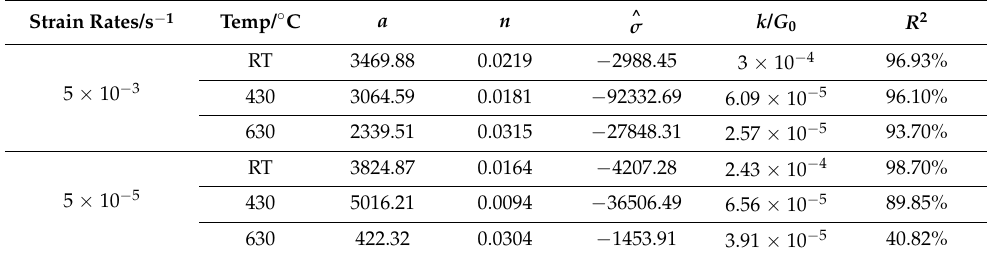
Table 5. Fitted values of the PB model under different temperatures at the strain rates of 5 × 10 − 3 s − 1 and 5 × 10 − 5 s − 1 .